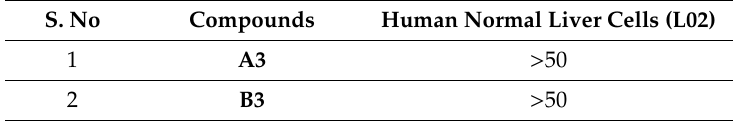
Table 4. Cytotoxicity of compounds A3 and B3 against human normal liver cells (IC 50 , µ g / mL)